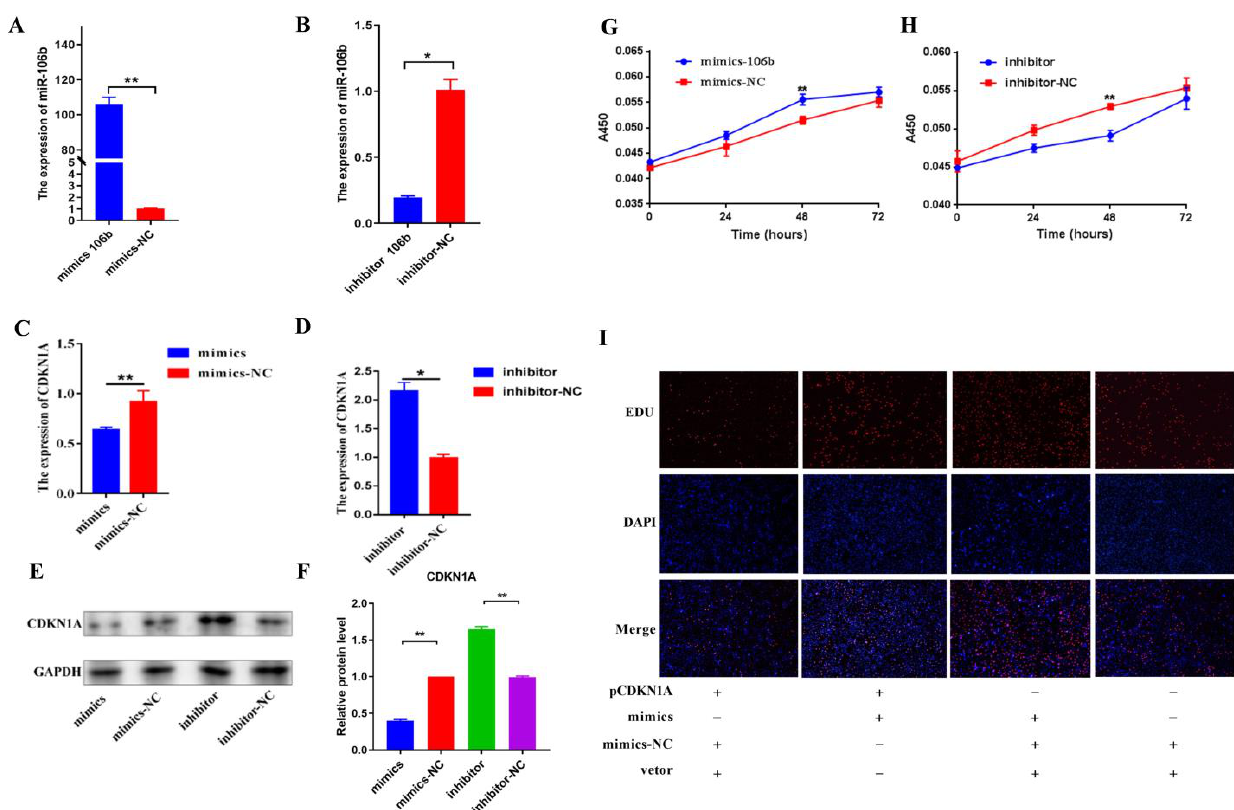
Figure 3. Bta-miR-106b regulated cell proliferation by targeting CDKN1A in BMECs. ( A , B ) The expression levels of bta-miR-106b at 48 h after transfection with bta-miR-106b mimics and inhibitors. ( C , D ) The mRNA levels of CDKN1A after transfection with bta-miR-106b mimics and inhibitors with qRT-PCR. ( E , F ) The protein expression of CDKN1A after transfection with bta-miR-106b mimics and inhibitors with Western blot. ( G , H ) The cell proliferation of BMECs at 0, 24, 48, and 72 h after transfection of bta-miR-106b mimics and inhibitors. ( I ) The proliferating BMECs were labeled with EdU. The click-it reaction revealed the EdU staining (red). The cell nuclei were stained with DAPI (blue). (Note: * means p value < 0.05; ** means p value < 0.01 . ).